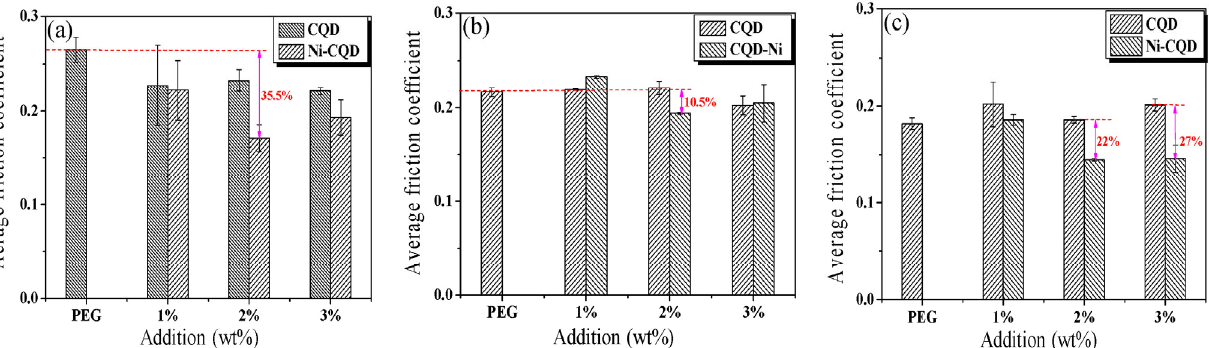
Fig. 3 Variation of average friction coefficient for different oil samples including the 1 wt%, 2 wt% and 3 wt% CQD or Ni-CQD particles at the reciprocation speed of 25 mm/s for 60 min at room temperature conditions under the different loads with: (a) 8 N; (b) 20 N; (c) 100